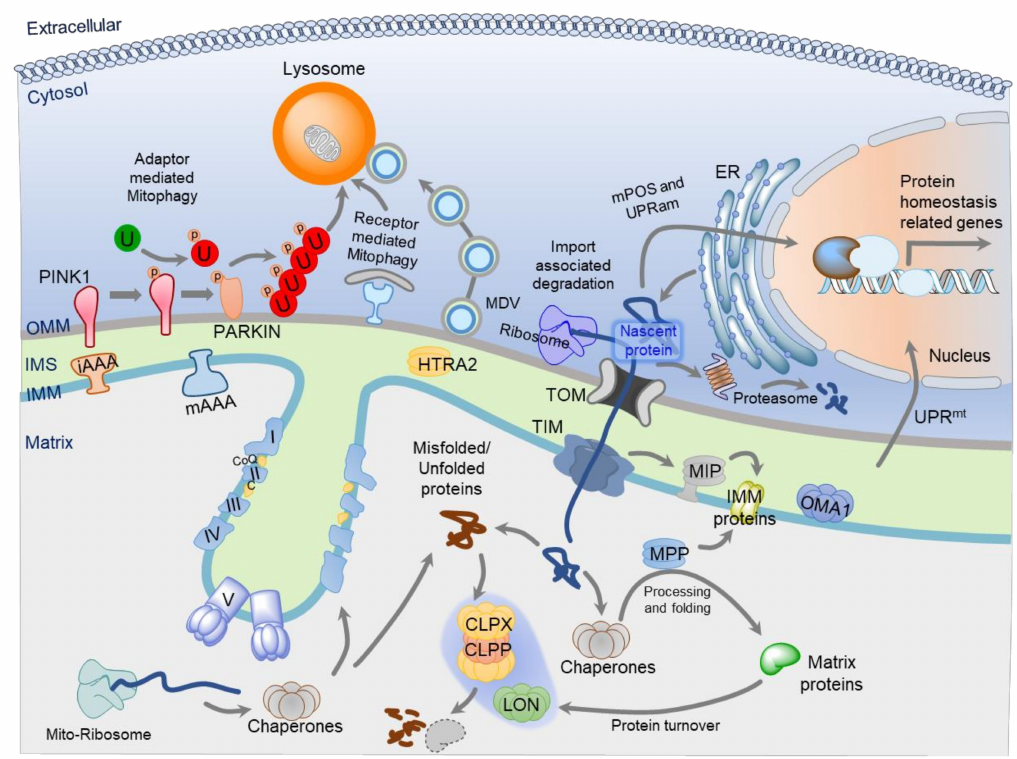
Figure 1. Overview of the Mitochondrial Protein Quality Control System (MPQC). Mitochondria maintain their protein-quality control at various steps and protect cells against proteotoxic stress. Most of the mitochondrial proteins are synthesized at ribosomes anchored to OMM or ER